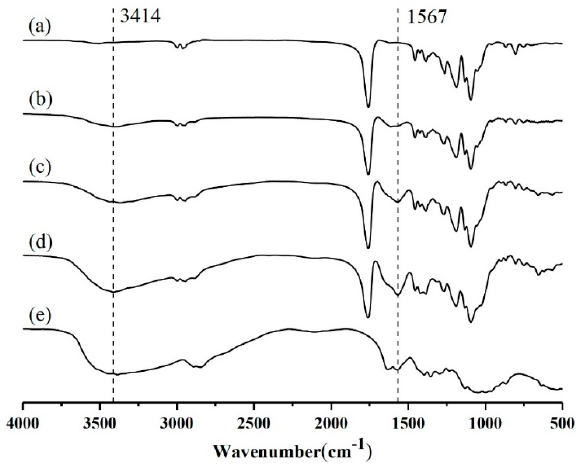
Figure 4. FTIR spectra: ( a ) PLGA; ( b ) CS/PLGA = 0.2; ( c ) CS/PLGA = 0.4; ( d ) CS/PLGA = 0.8; ( e ) CS.